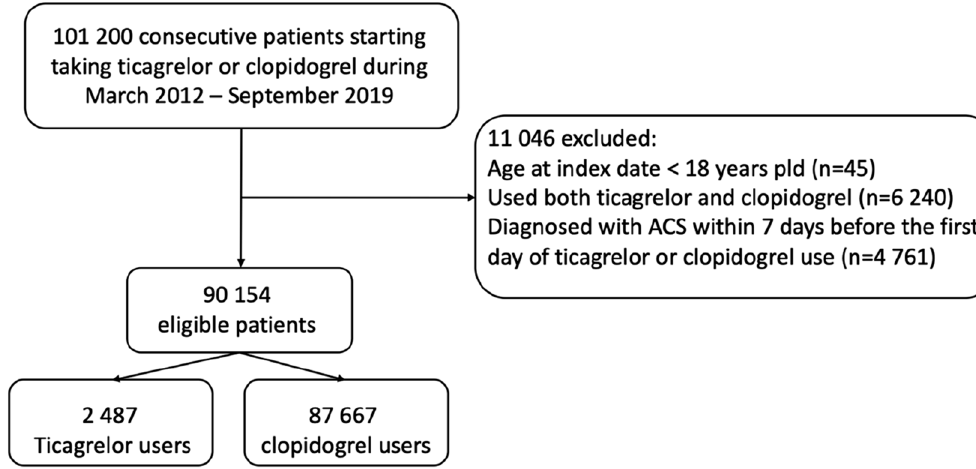
Figure 1. Flowchart for patient selection.